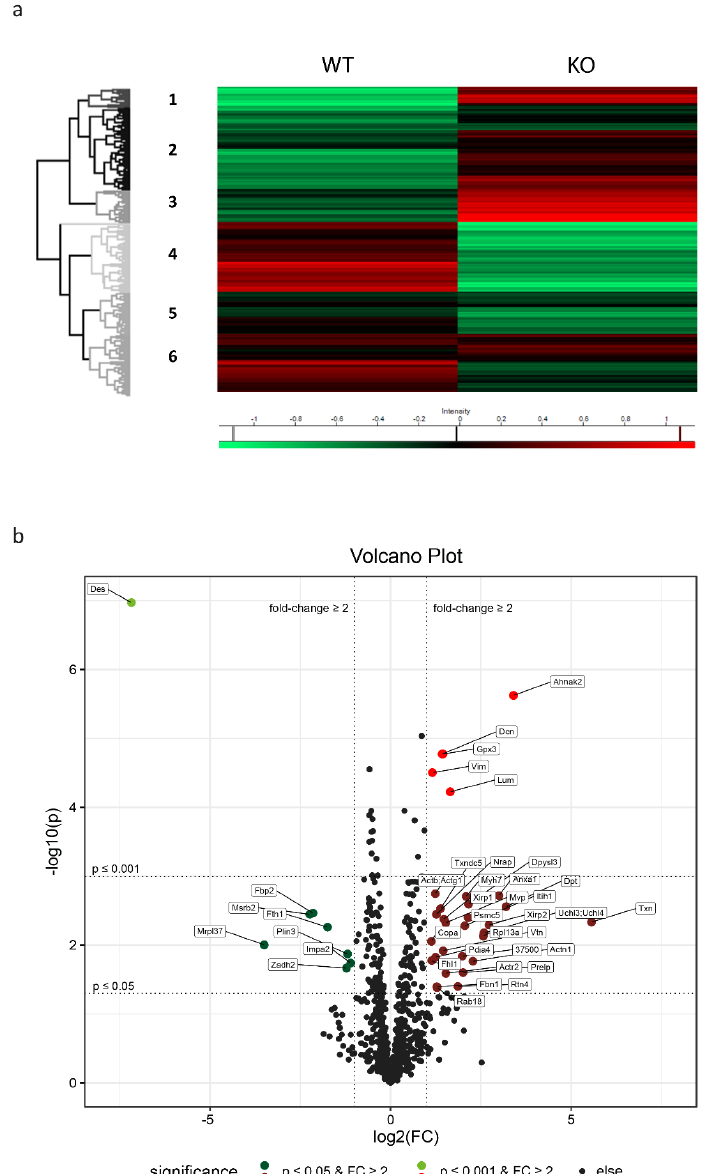
Figure 6. Quantitative proteomic analysis of left ventricular cardiac tissue derived from desmin knock-out mice. ( a ) Hierarchical clustering of the proteomic data created a dendrogram with six distinct clusters. Clusters 1 to 3 showed higher protein amounts in the desmin knock-out cardiac tissue, while clusters 4 to 6 highlighted reduced protein amounts as compared to their wild-type sibling derived tissue. The heat map indicates increased protein levels in red and decreased values in green. For a list of all proteins used for hierarchical clustering please refer to Table S1; for a bubble plot illustration of the “Gene Ontology (GO) term Cellular compartment (CC)” and “Kyoto Encyclopedia of Genes and Genomes (KEGG) pathway” enrichments please refer to Figure S1. ( b ) Volcano plot comparing protein levels of desmin knock-out and wild-type genotypes. X -axis, log 2 -transformed mean fold change; y -axis, -log 10 -transformed p -value. Light red and dark red as well as light and dark green dots indicate significantly up- and down-regulated proteins, respectively, with p -values of ≤ 0.05 or ≤ 0.001 and a fold-change ≥ 2. For lists of significantly up- and downregulated proteins as well as all quantified proteins including non-significantly regulated and proteins of any fold-change in desmin knock-out left ventricular cardiac tissue please refer to Table